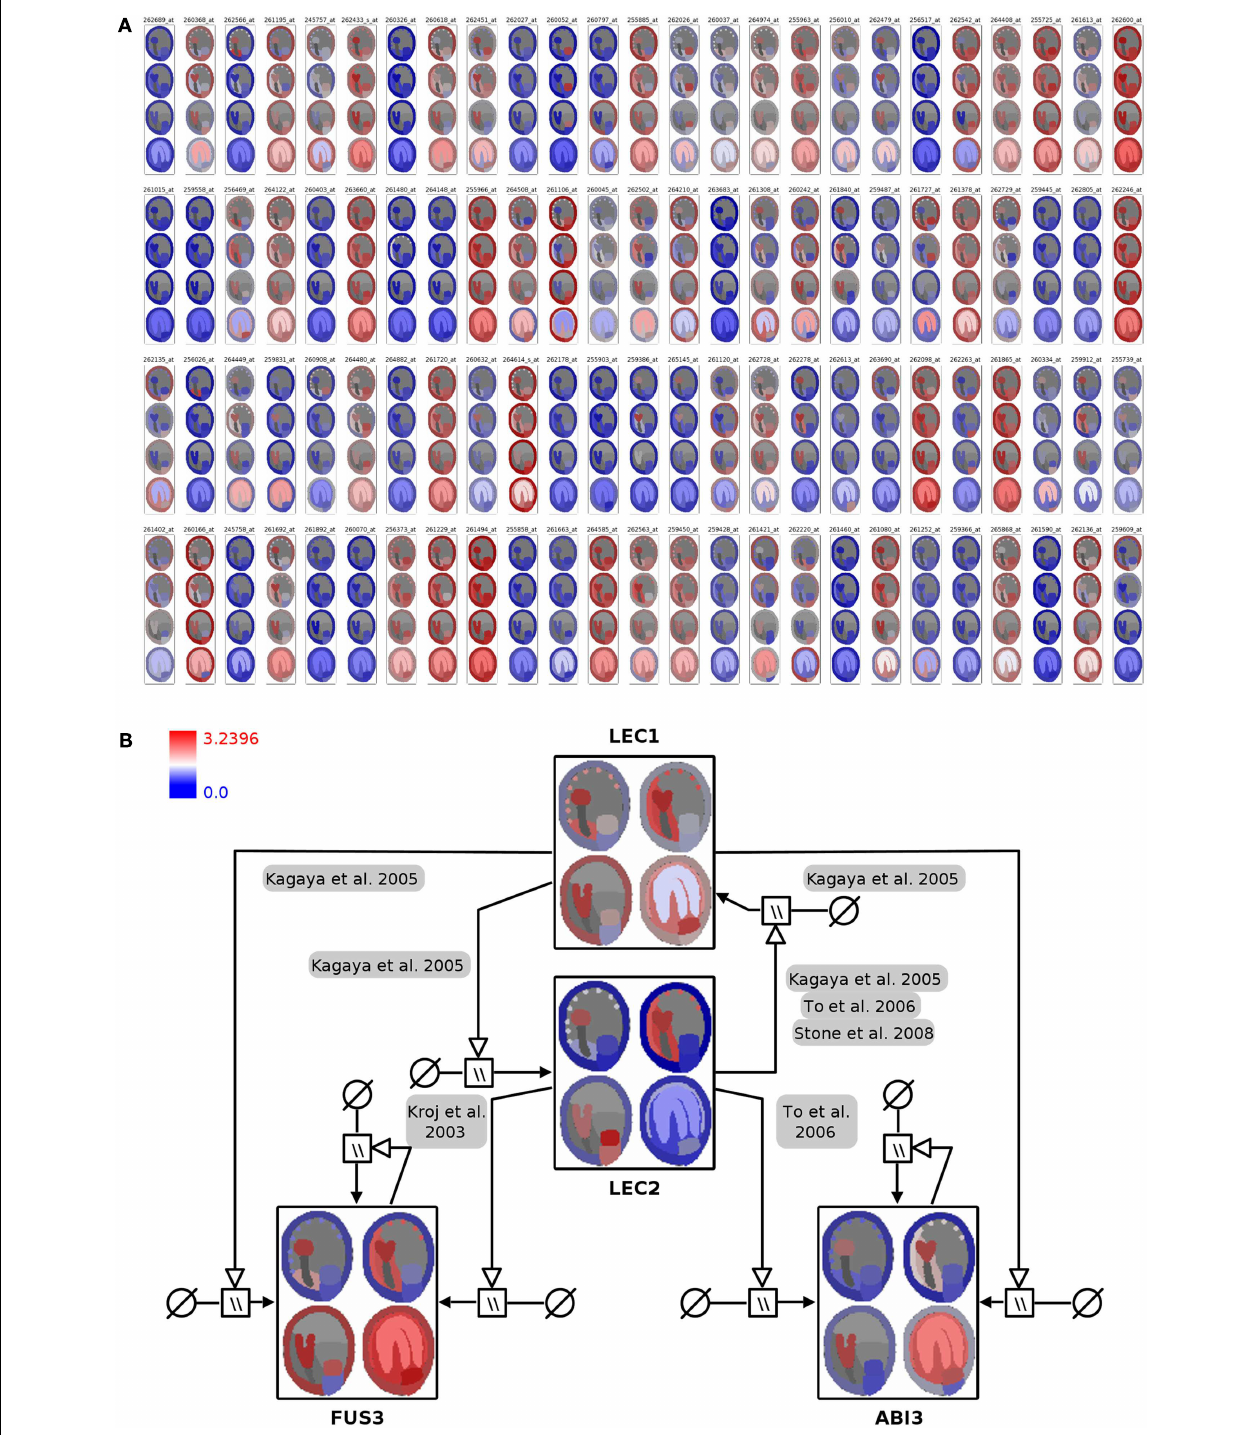
Stone et al., 2008) whereas LEC2 in turn controls FUS3 and ABI3 (Kroj et al., 2003;To et al., 2006). During linear cotyledon and green mature stages expression of LEC1 and LEC2 ceases and expression levels of FUS3 and ABI3 stay constant due to autoregulatory loops (Kroj et al., 2003;To et al., 2006). For detailed explanations about the used SBGN Process Descriptions glyphs the reader is referred to (Junker et al., 2010). Please note that the arrangement of the four seed images was adapted from a vertical row in (A) to a 2 × 2 matrix arrangement in (B) for layout